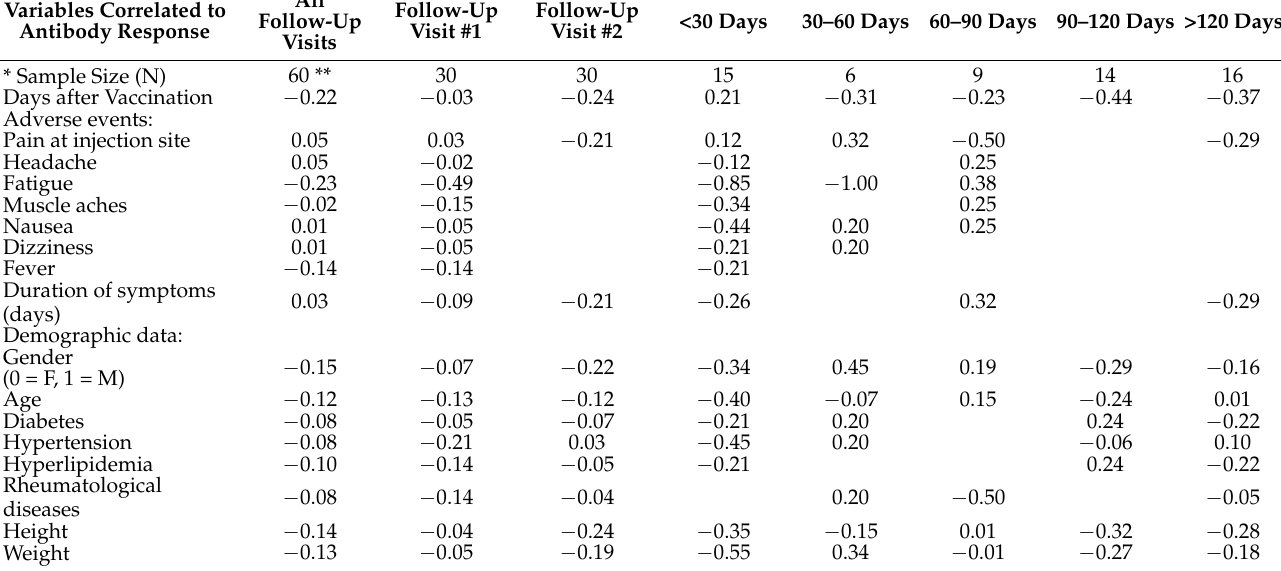
Table 3. Correlation table between antibody results (negative or positive) and the